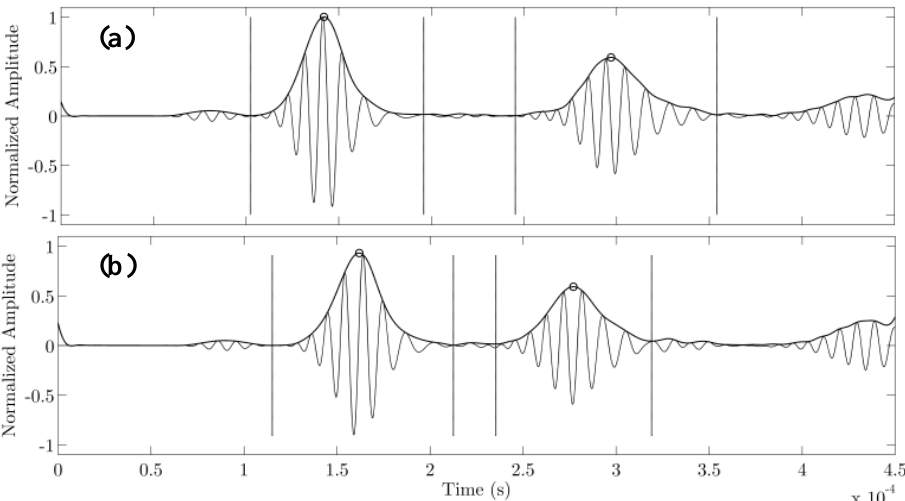
Figure 5. Wavepacket detection and boundary determination established by the algorithm for two signals acquired at: ( a ) 30 cm and ( b ) 35 cm from the transmitter using a d 33 -type transducer.